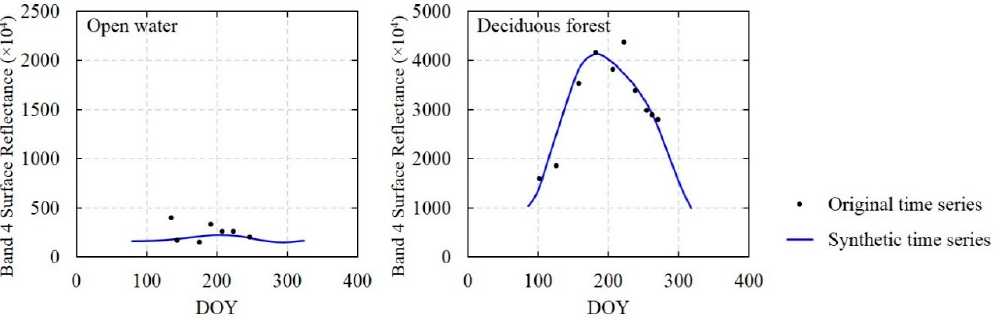
Figure 6. Illustration of Landsat band-4 time-series for open water and deciduous forest in 2011.